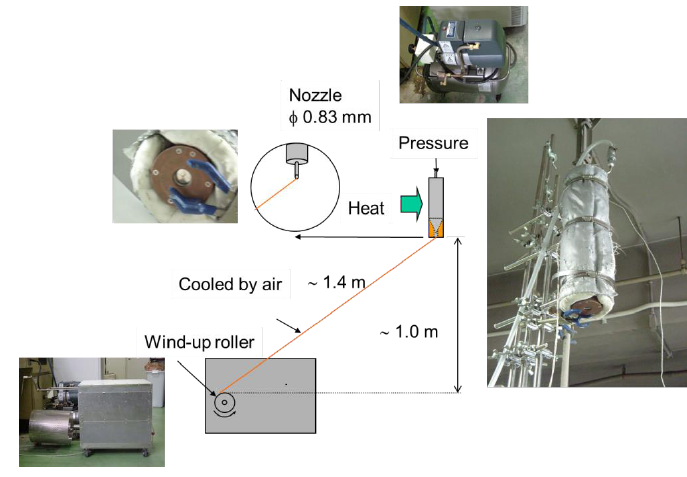
Figure 1. Dry-spinning apparatus.